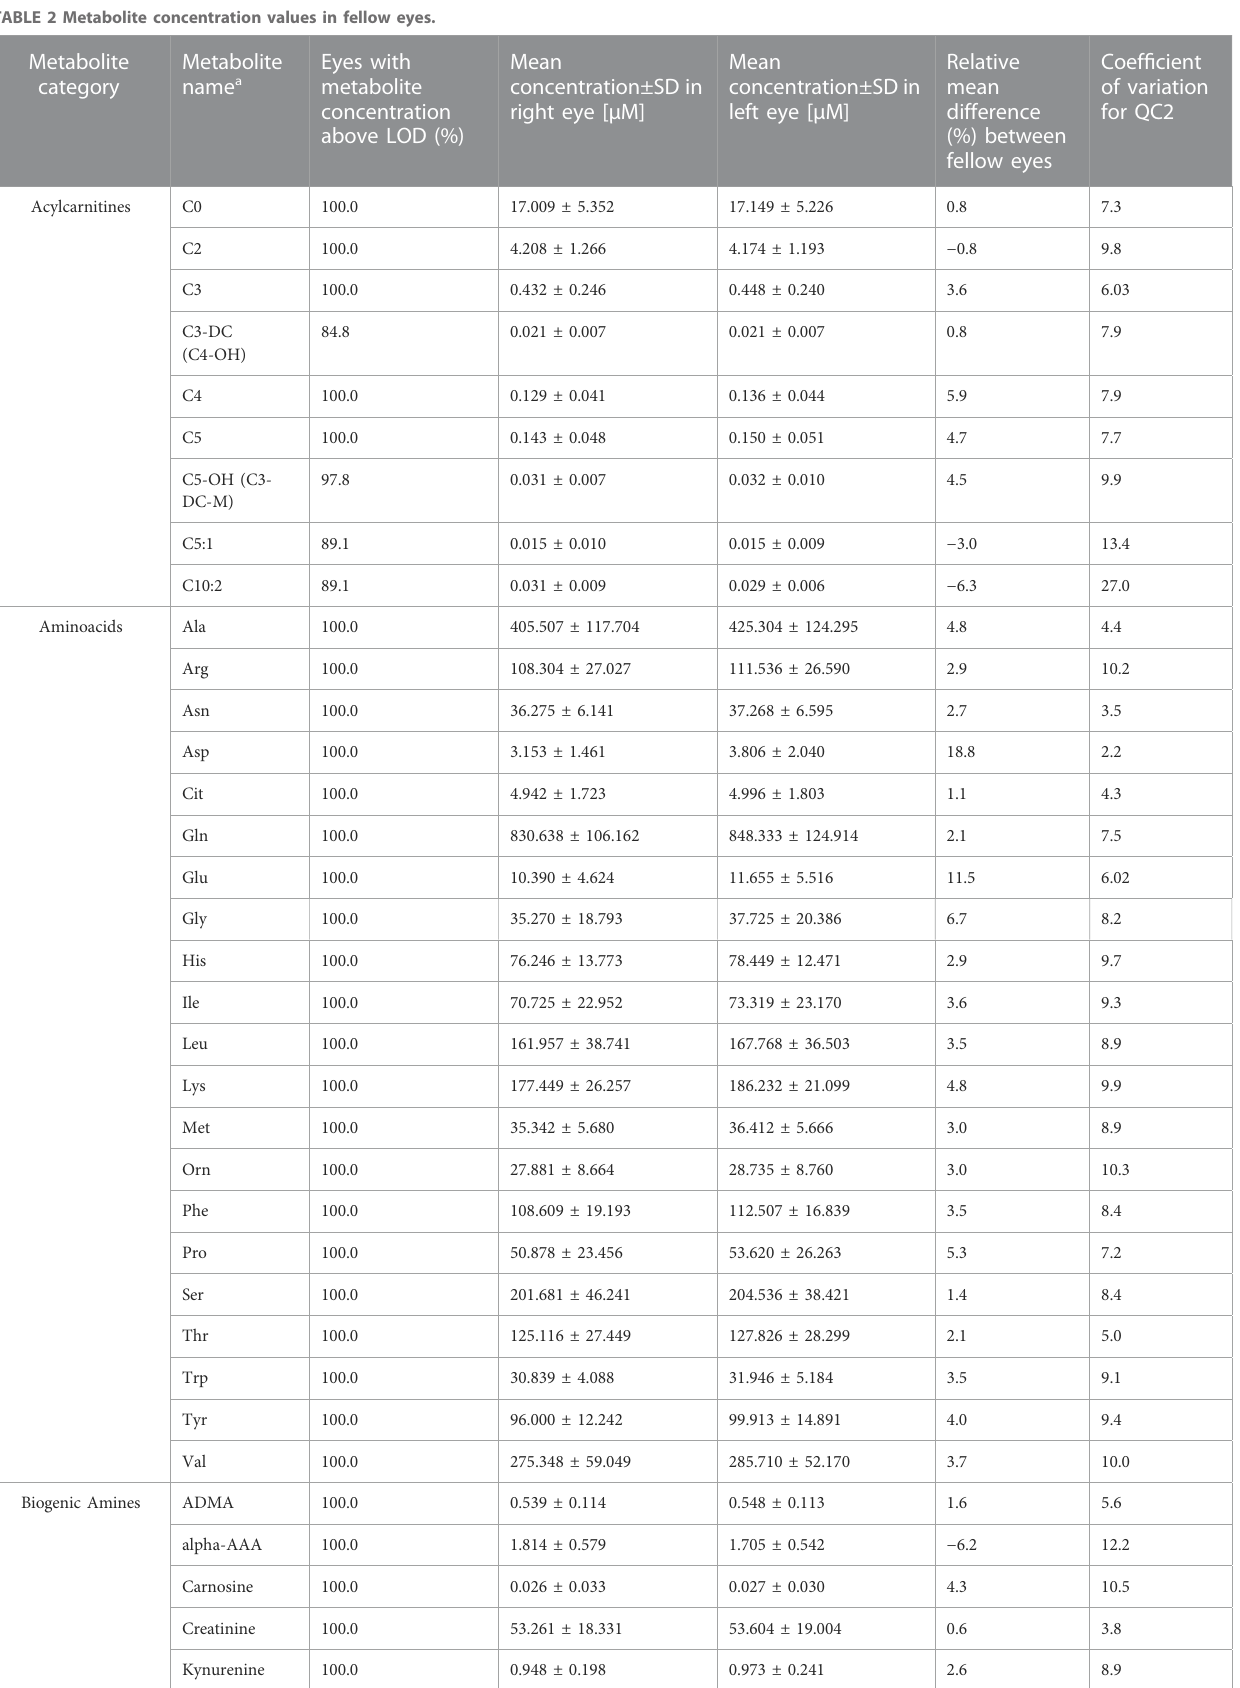
TABLE 2 Metabolite concentration values in fellow